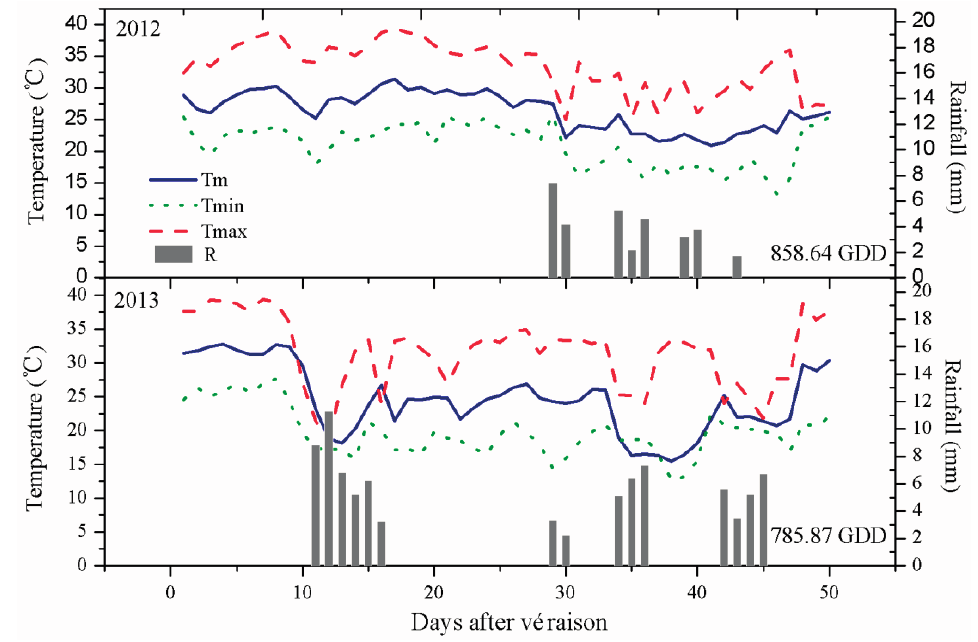
Figure 1. Patterns of mean (T m ), maximum (T max ), and minimum (T min ) daily temperatures and rainfall (R) from véraison to commercial harvest in the study area in 2012 and